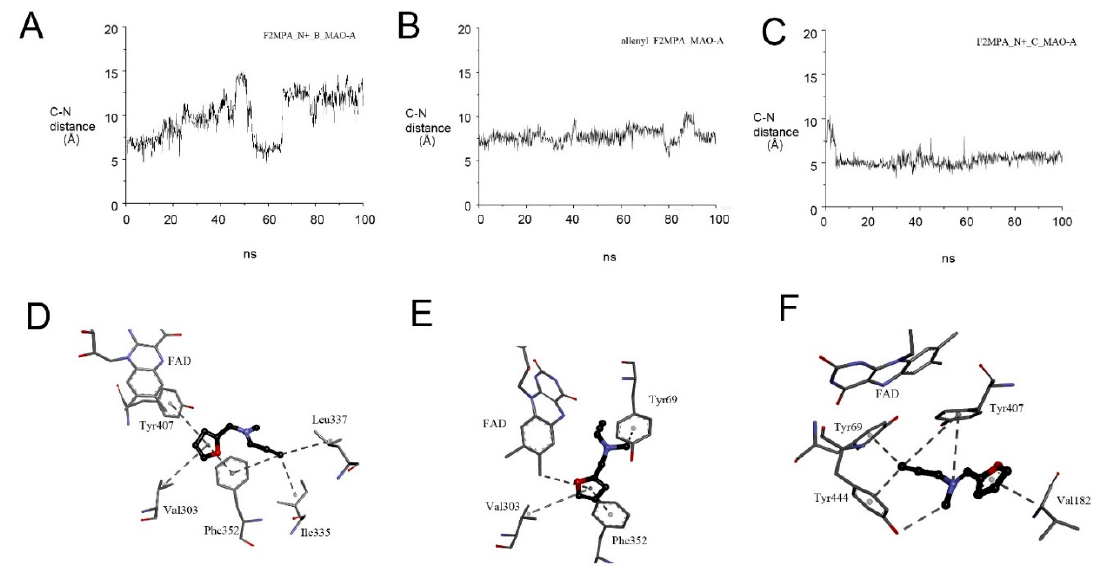
Figure 13. The potential products of F2MPA oxidation bind close to FADH − in reduced MAO-A. Top: the atom plot distances for the imine C-terminal to N5 of FADH − . Bottom, the poses in reduced MAO-A. ( A , D ) the imine C α P product; ( B , E ) the allenyl C α P product; ( C , F ) the furfuryl C α F product. Poses taken at ( D ) 90 ns; ( E ) 80 ns; ( F ) 90 ns.